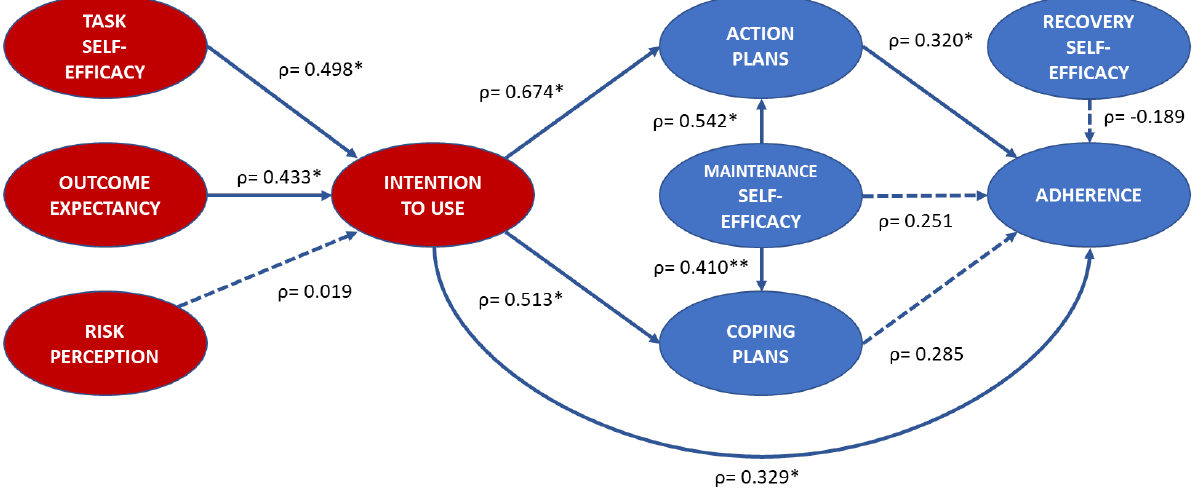
Figure 1. Spearman Rank Order Correlation ( ρ ) for post-season HAPA construct scores. Solid line signifies * p < 0.05.